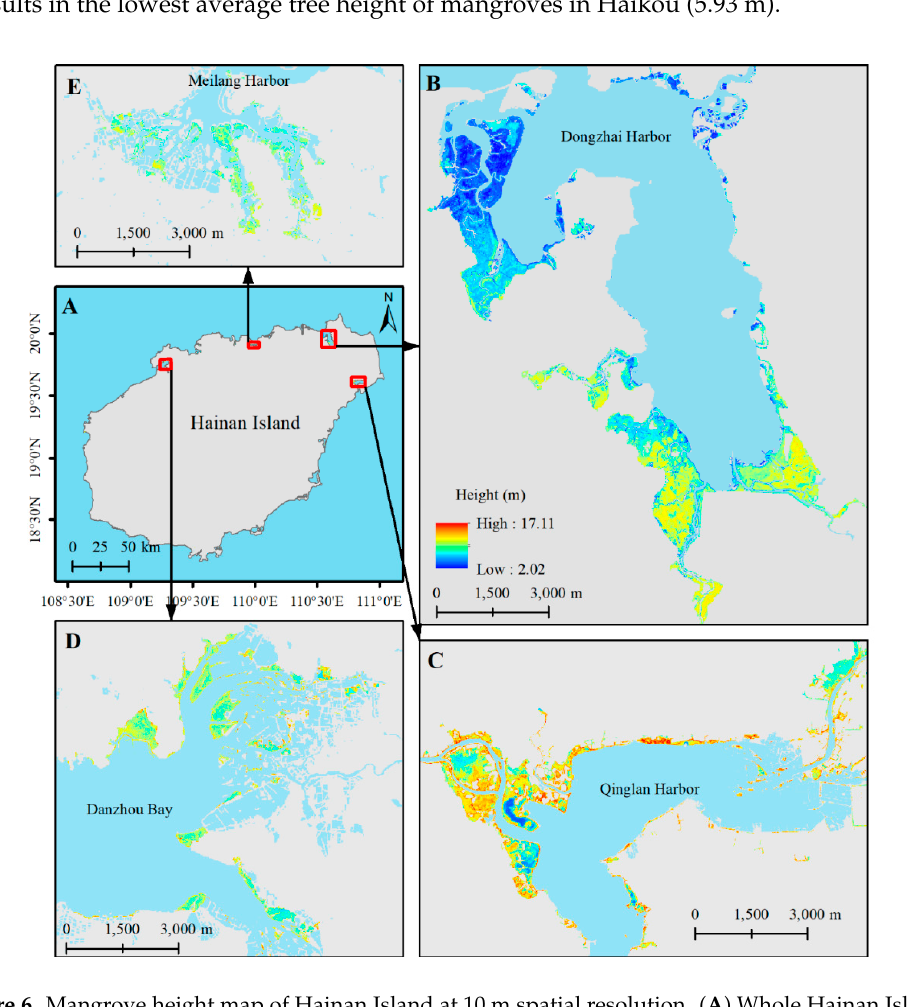
Figure 6. Mangrove height map of Hainan Island at 10 m spatial resolution. ( A ) Whole Hainan Island, ( B ) Dongzhai Harbor, ( C ) Qinglan Harbor, ( D ) Danzhou Bay, and ( E ) Meilang Harbor.